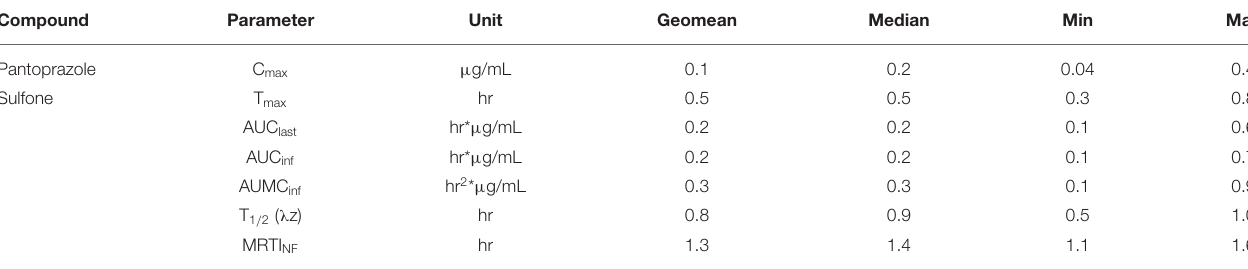
TABLE 2 | Pantoprazole sulfone pharmacokinetic parameters following a single intravenous (1 mg/kg) administration of pantoprazole sodium to adult goats. Compound Parameter Unit Pantoprazole